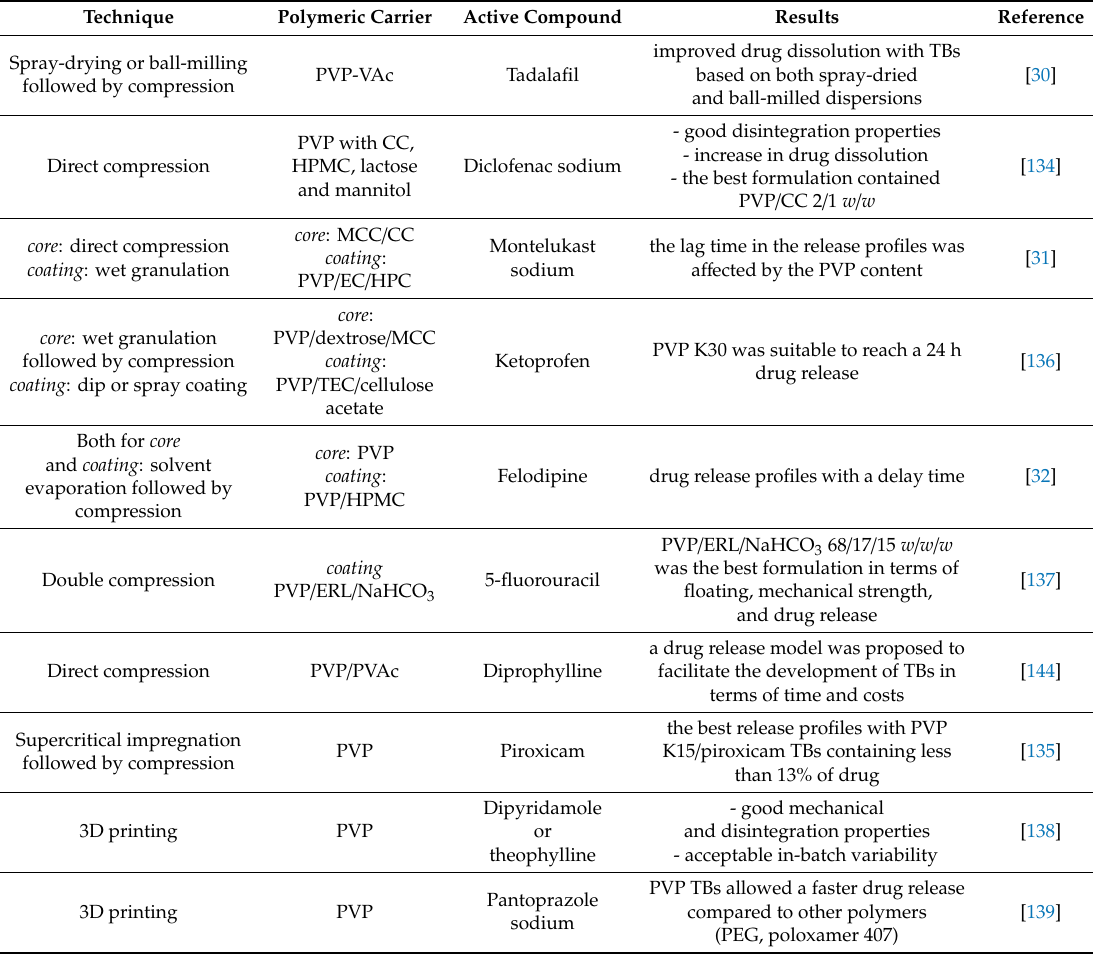
Table 4. PVP-based tablets. TBs, tablets; VAc, vinyl acetate; CC, cross-carmellose; HPMC, hydroxypropyl methylcellulose; MCC, microcrystalline cellulose; EC, ethyl cellulose; HPC, hydroxypropylcellulose; TEC, triethyl citrate; ERL, Eudragit RL; PVAc, poly(vinyl acetate); PEG, polyethylene glycol. Technique Results